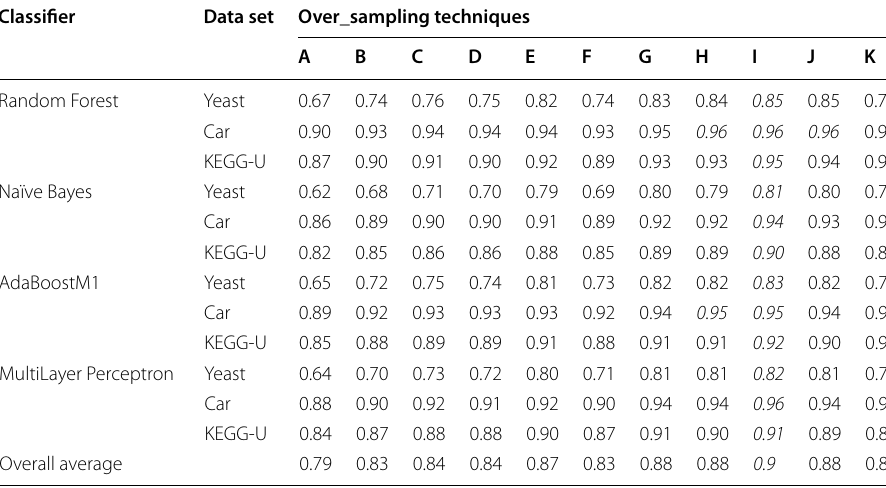
Italic values indicate highest